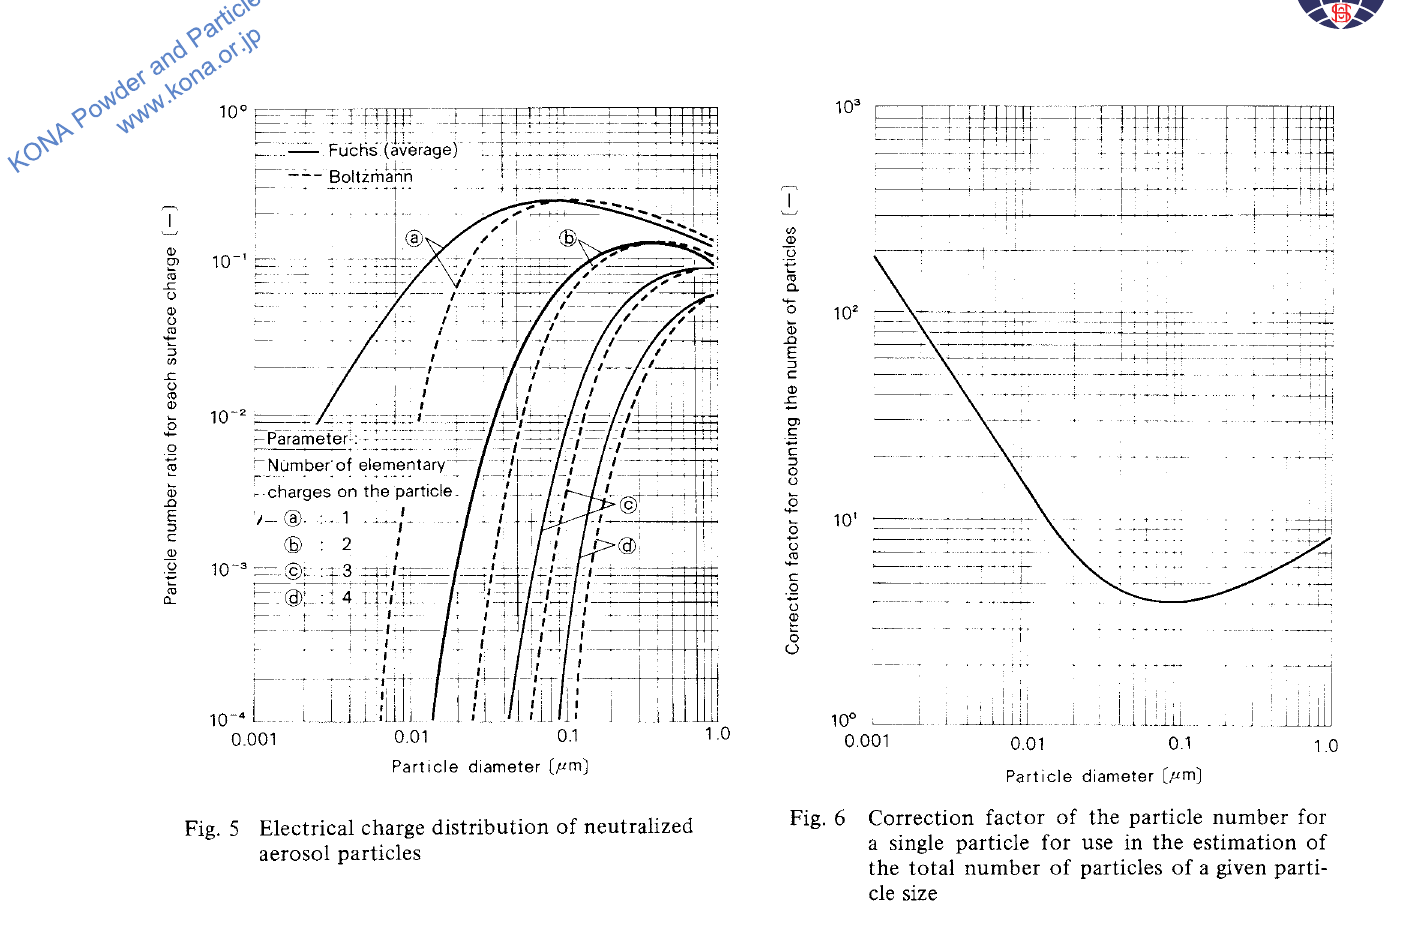
Fig. 5 Electrical charge distribution of neutralized aerosol particles